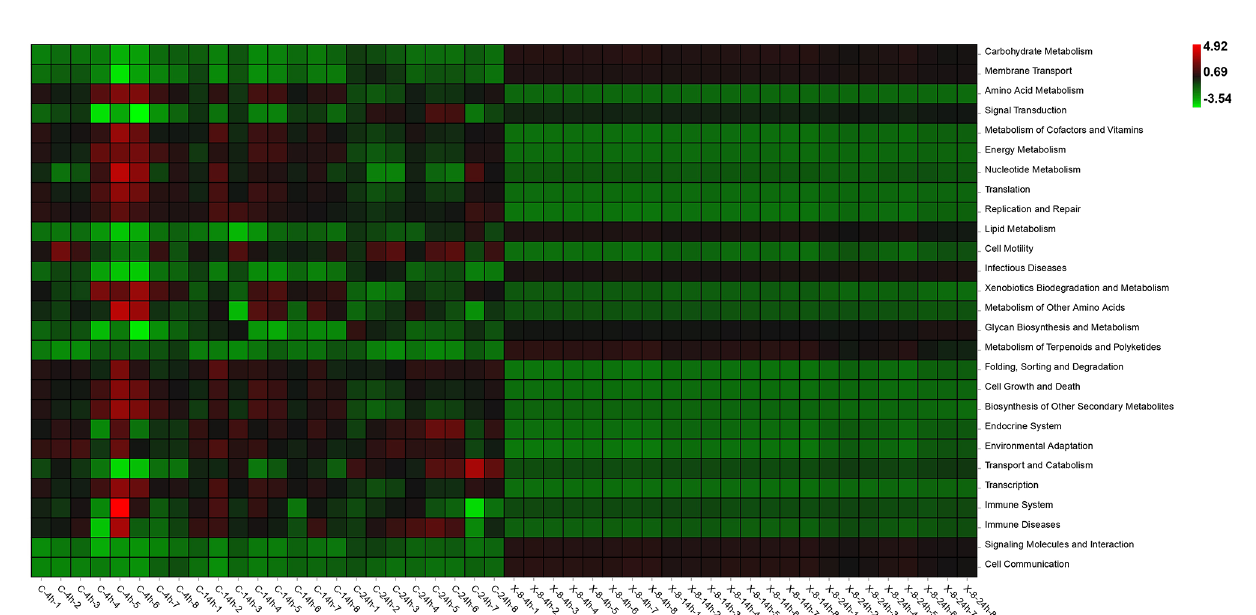
FIGURE 6 | Functional prediction of epibacterial communities associated with S. japonica . C, control group; X-8, PpX-8infected group. 4 h, 14 h and 24 h were sampling